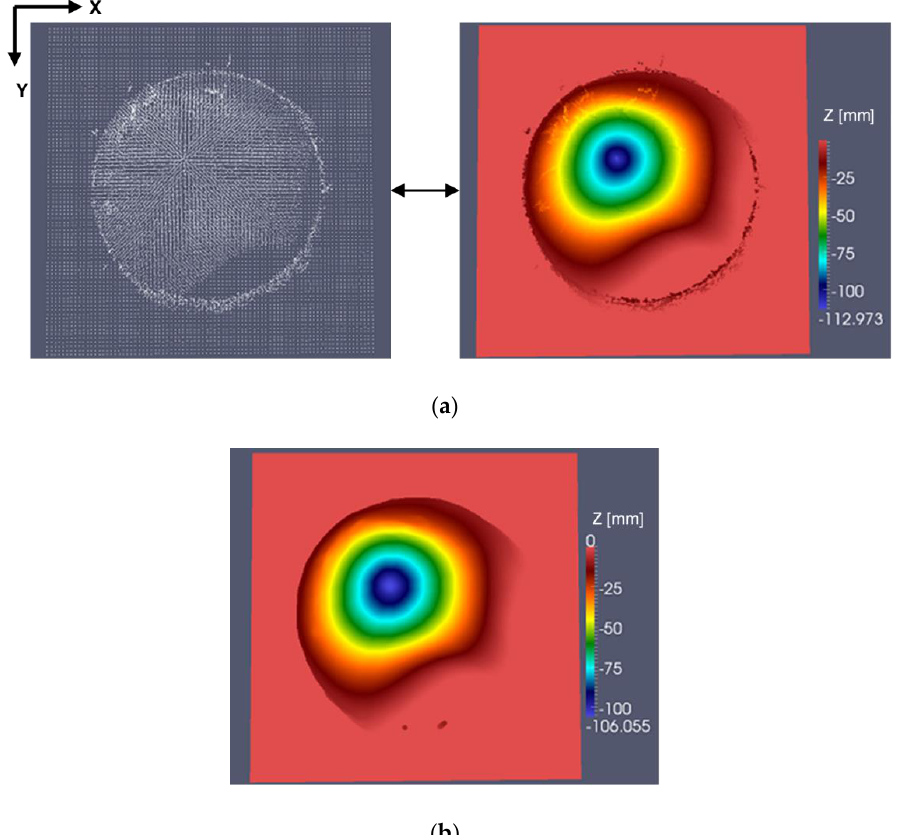
Figure 17. Procedure to generate the reference rectangular grid for denoising : ( a ) rectangular grid considered as a 2D image: in the right-hand image the z coordinates of the grid points are mapped to the color of the image; ( b ) reference rectangular grid for denoising obtained by using a median 11 × 11